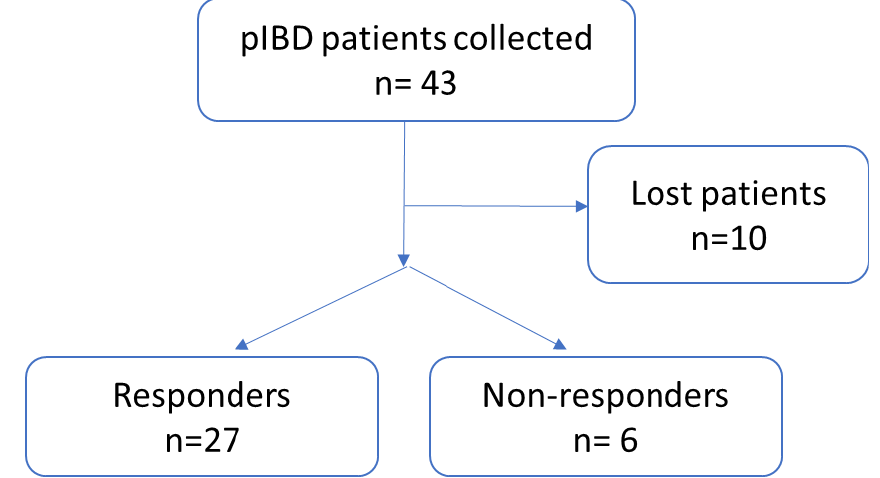
Figure 1. Flow chart showing selection of study patients. pIBD, pediatric inflammatory bowel disease. Some patients were lost because paxgene could not be collected at time 0 or 2, some data were missing or the quality of cDNA was insufficient.